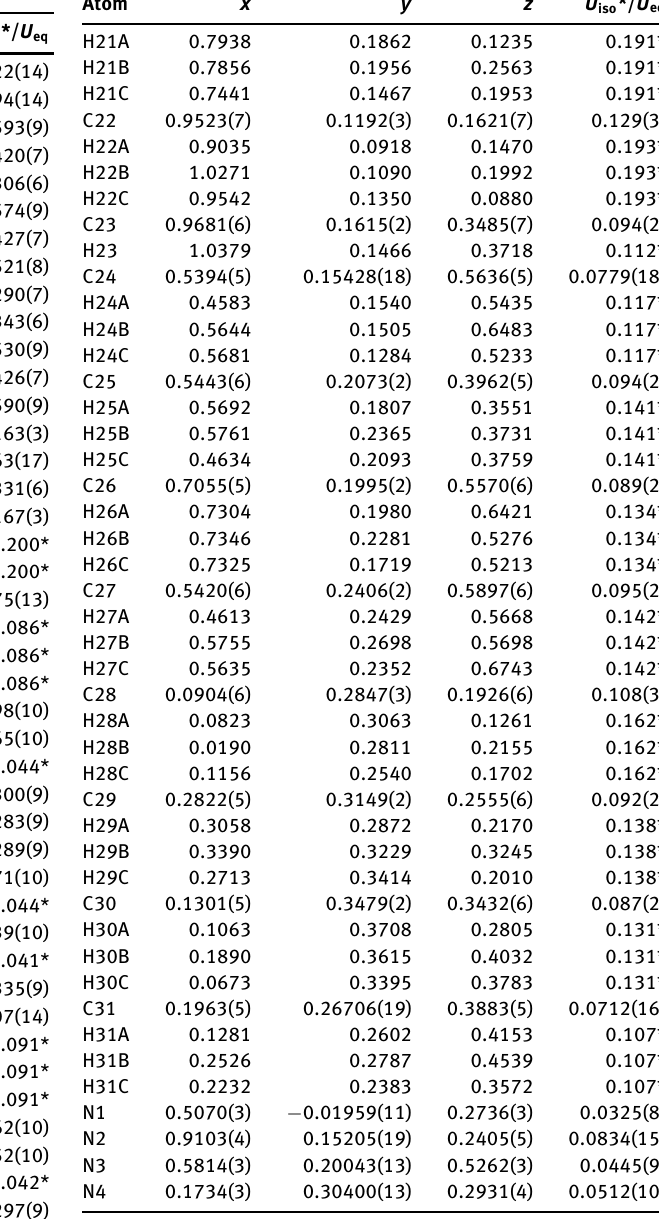
Table 2: Fractional atomic coordinates and isotropic or equivalent isotropic displacement parameters (Å 2